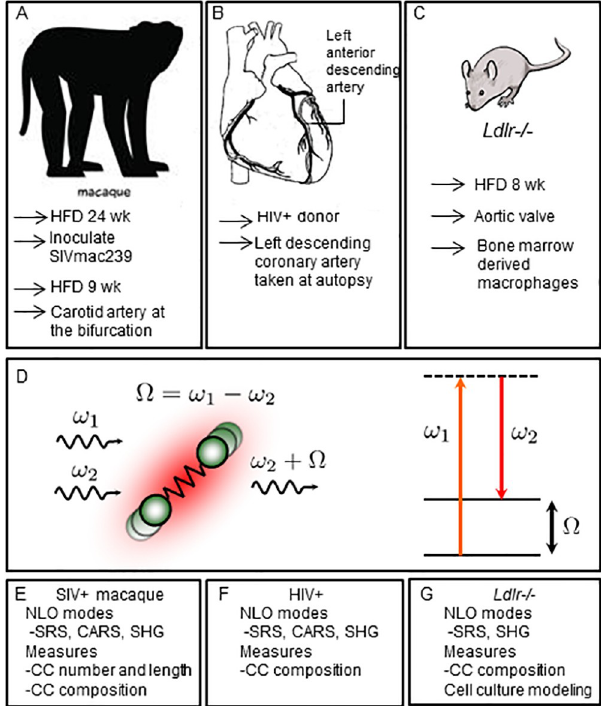
Fig 1. Atherosclerotic models and plaque imaging by stimulated Raman loss. Plaque samples were derived from three sources, (A) a study of male Macaques on a high fat diet for 24 weeks, inoculated with SIVmac239, or not, and kept on diet another 9 weeks before sacrifice and analysis, (B) HIV + autopsy samples of the left anterior descending coronary artery, (C) a study of Ldlr -/- mice fed a high fat diet for 8 weeks. (D) Diagram of the mechanism of the stimulated Raman loss process, where ω 1 and ω 2 are the frequencies of the incoming photons, and O corresponds to the frequency of the molecular vibration. (E-F) Imaging modalities used and measures taken in the models. https://doi.org/10.1371/journal.pone.0251599.g001 uninfected animal (panels A-C), while the lower panels are from a SIV + animal (D-F). The SRS channel is colored red (Fig 2, panels B & E), while data captured in the SHG mode, where image contrast is uniquely sensitive to the non-centrosymmetric ordering of crystalline choles- terol, is shown in blue (Fig 2, panels A & D), with the merged images shown in panels C & F.